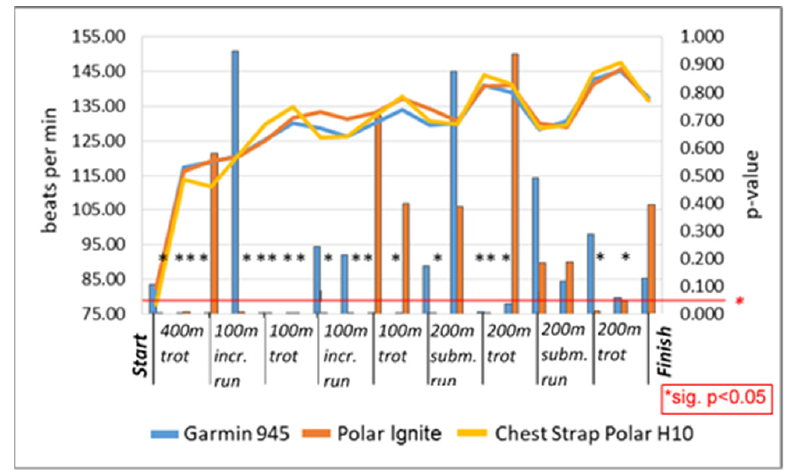
Figure 1. Bland–Altman diagrams of heart rate measurements ( n = 36). ( a ) Garmin 945 vs. crite- rion, ( b ) Garmin 945 vs. criterion without swim, ( c ) Polar Ignite vs. criterion, ( d ) Polar Ignite vs. criterion without swim, ( e ) Garmin 945 vs. Polar Ignite, ( f ) Garmin 945 vs. Polar Ignite without swim, ( g , h ) heart rate lines Garmin 945, Polar Ignite and chest trap Polar H10 ( g ) swim 500 m, ( h ) swim 1000 m; min = minute, mean = mean value, SD = standard deviation of the difference.